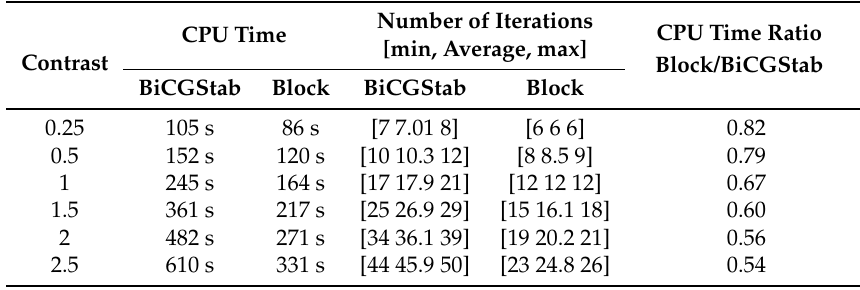
Table 2. CPU time and number of iterations required for computing the 160 forward simulations with BiCGStab and block-BiCGStab for different contrast levels. Results are averaged over the 160 resolutions for BiCGStab and over 20 realizations of the random initialization for block-BiCGStab. CPU